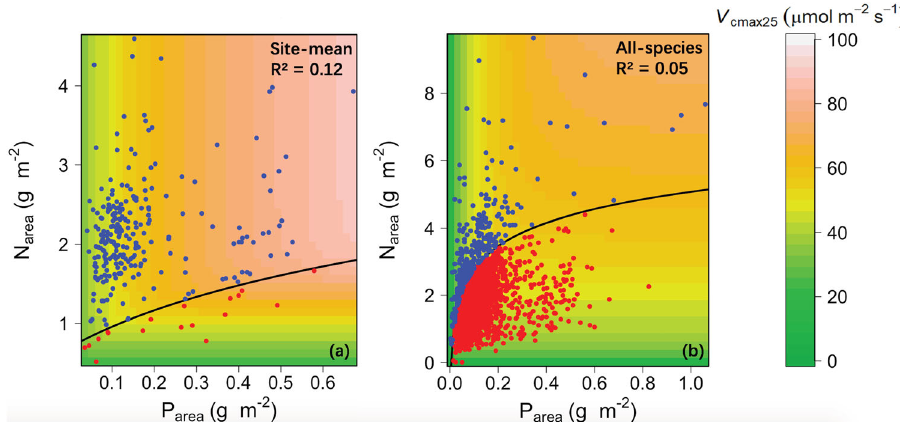
Fig. 5 Visualizing the co-limitation of V cmax25 by Narea and Parea based on the minimum function model. Visualizing the co-limitation of V cmax25 by Narea and Parea for global ( a ) site-mean and ( b ) all-species analyses, based on the minimum function model. Following Domingues et al.8, blue points represent cases where Parea was the ‘ limiting ’ nutrient; red points represent cases where Narea was the ‘ limiting ’ nutrient. The fi tted regression line in ( a ) is Narea = ln (5.96 Parea + 2.01) and in ( b ) is Narea = ln (158.62 Parea